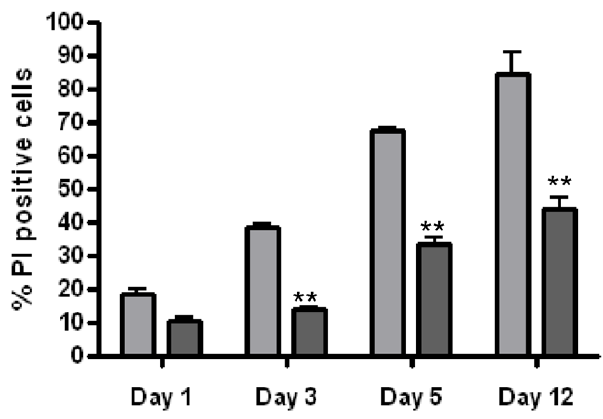
Figure 8. Differentiated PC12 cells exposed to RT43.2GFPBcl- xL vectors are rendered less susceptible to death attributable to NGF withdrawal. PC12 cells were plated on Matrigel-coated wells, and treated with 100 ng/ml NGF for five days. Differentiated cells were transduced with RT43.2GFP (grey) or RT43.2GFPBcl-xL (black) vectors during continued treatment with NGF. Three days after infection, the cells were washed with serum-free and NGF-free medium once and fed with serum-free and NGF-free medium for different intervals. PI and Hoechst33342 were added and the cells photographed using a 20 6 objective using either a rhodamine or DAPI filter. Percentage of PI positive cells versus Hoechst33342 stained total cells is represented by the mean value of several fields obtained from three experiments. *P , 0.001.